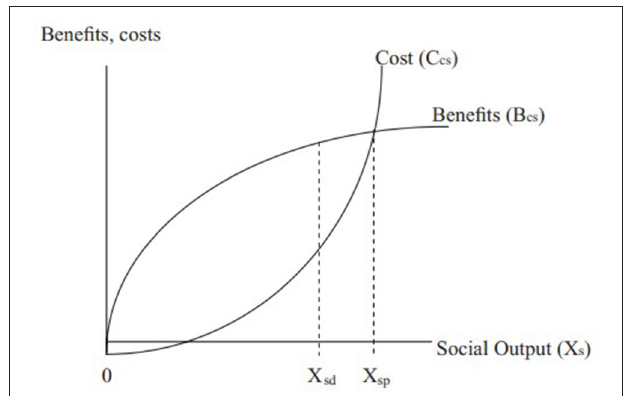
FIGURE 3 | Optimum social investment in the case of altruism. Source: Husted and Salazar